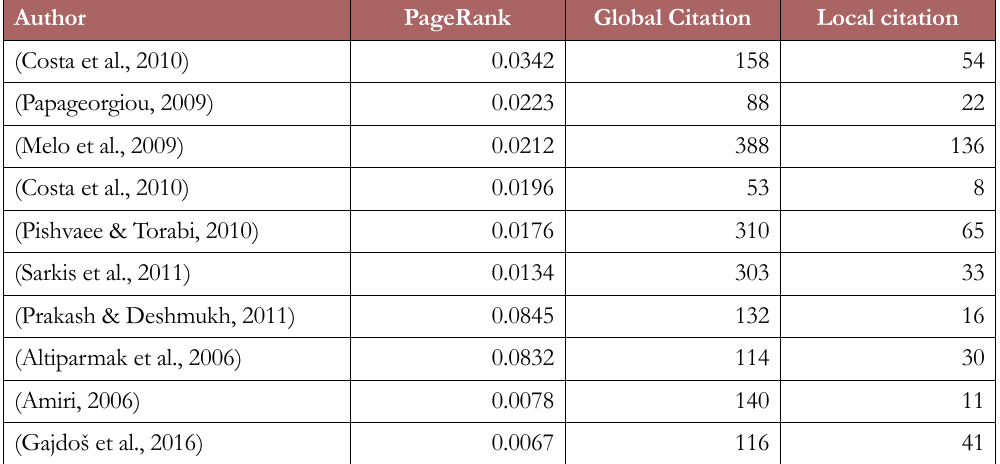
Table 10. The top authors with 8 or more articles with PageRank